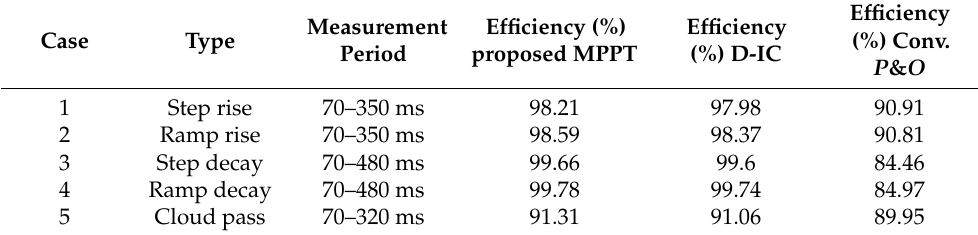
Table 3. Efficiency table of algorithms under five dynamic weather